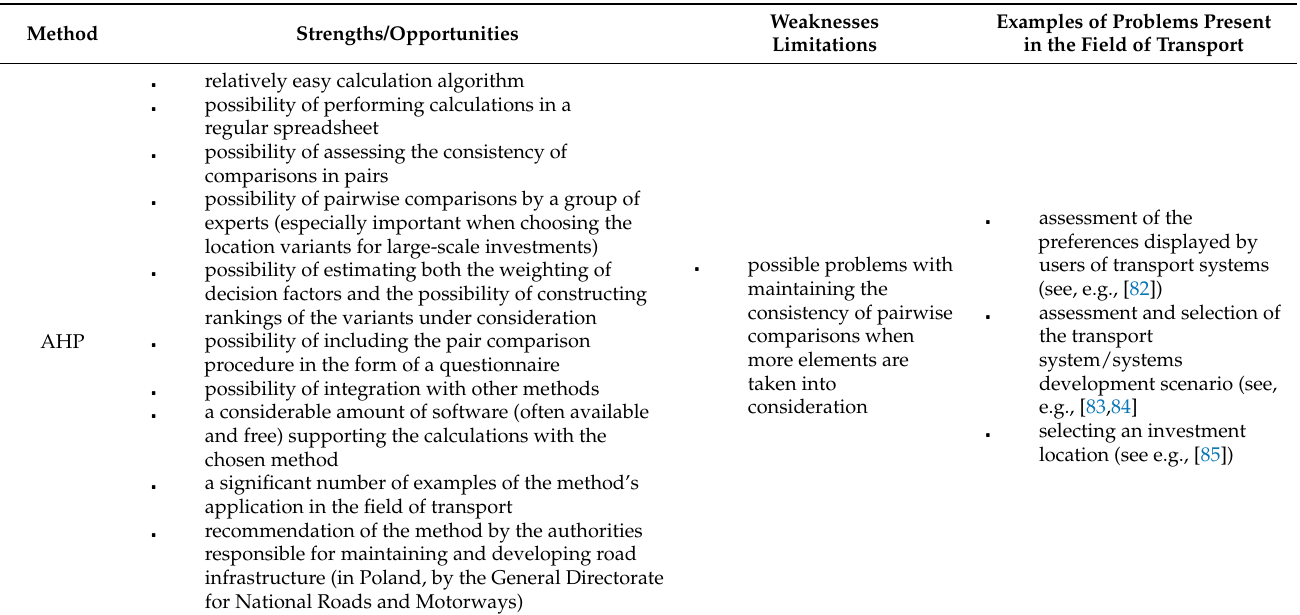
Table 14. Assessment of the most popular MCDM/MCDA methods used so far in the field of transport with their SWOT analysis and examples of